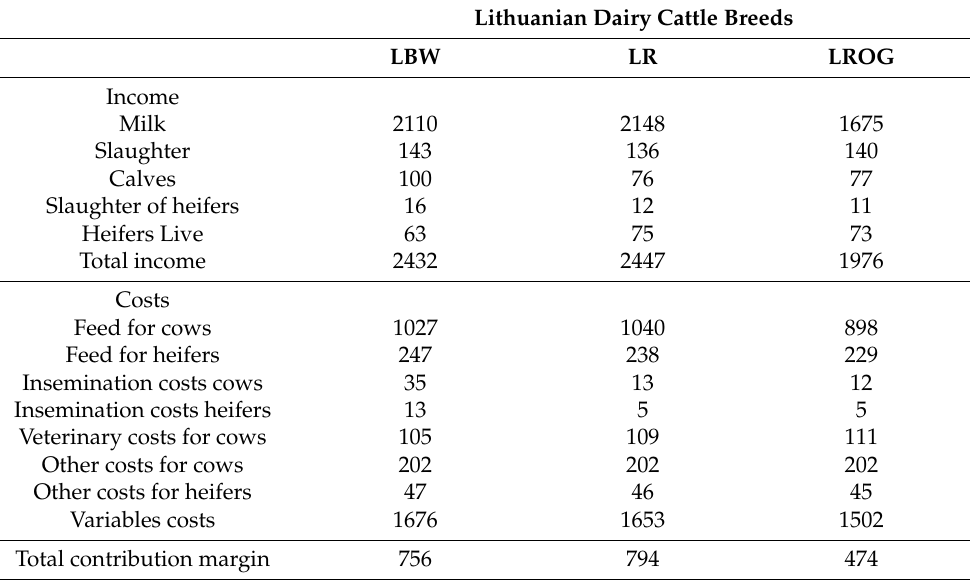
Table 7. Simulated annual economic results (EUR/cow) in a herd of LBW, LR and